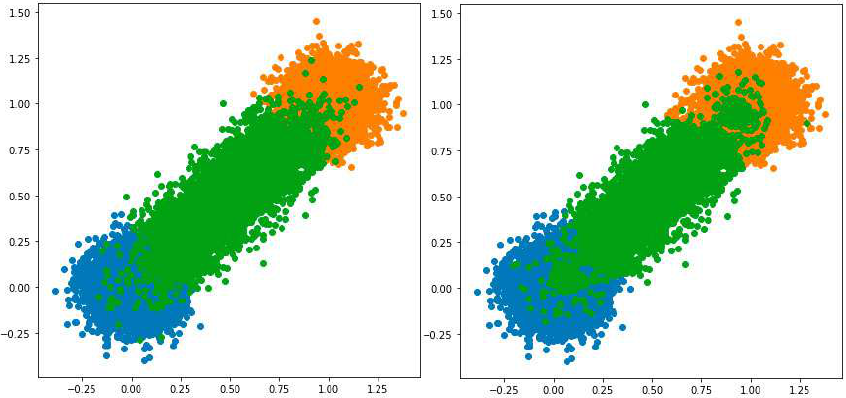
Figure 8. Example of instances from the DS 5 , classified by HPFuzzNDA (the left graph) and PFuzzND (the right graph) algorithms.